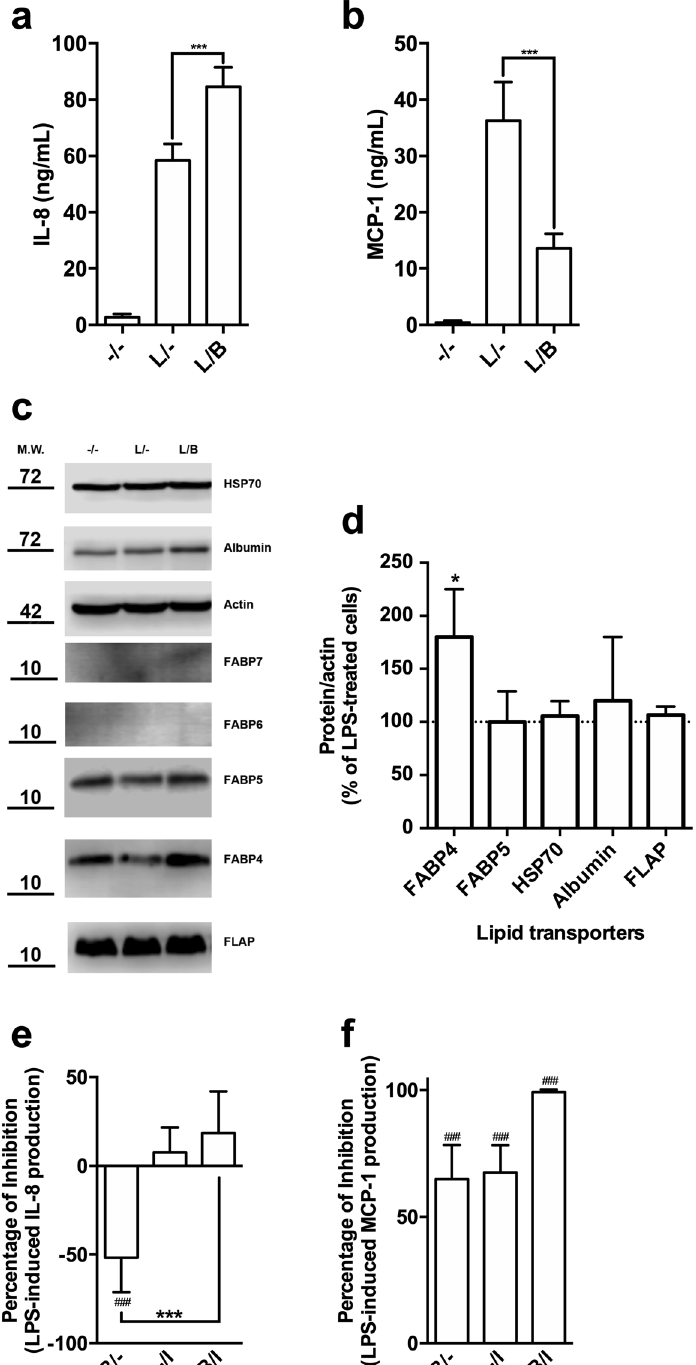
Figure 1. Study of the immuno-modulatory activity of bindarit on LPS-stimulated monocytes. MM-6 cells were left untreated ( − / − ) or were treated with 100 ng/mL LPS (L) for 20 hours, in the absence (L/ − ) or presence of 300 μ M bindarit (L/B). After treatment, IL-8 ( a ) and MCP-1 ( b ) levels were measured in cell supernatants by means of AlphaLISA. Values are means ± S.D. of 5 independent experiments, each performed in duplicate. Significance is shown as P value, calculated with an unpaired t -test. *** P < 0.001. ( c ) Representative immunoblot showing the expression profile of different lipid binding proteins in MM-6 cells left untreated ( − / − ) or treated with 100 ng/mL LPS (L) for 20 hours, in the absence (L/ − ) or presence of 300 μ M bindarit (L/B). Protein lysates were subjected to immunoblotting following 10% SDS-PAGE against the antibody indicated on the right side. Actin was also probed with anti-actin antibody to confirm equal protein loading. Molecular weights (M.W.) of protein markers (in kDa) are shown on the left side. The original scans were manipulated to remove irrelevant lanes and/or background regions. Full-length and original blots are presented in supplementary information. ( d ) Bar graph of the densitometric analysis of 5 independent experiments.